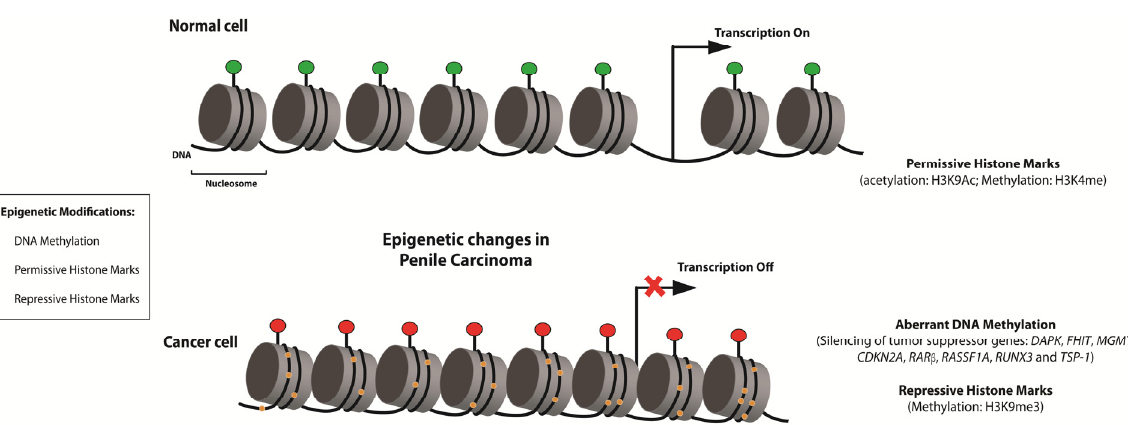
Figure 2. Epigenetic alterations were described in eight studies of penile carcinoma (PeCa). Aberrant DNA methylation pattern of DAPK , FHIT , MGMT , CDKN2A , RAR β , RASSF1A , TSP-1 , and RUNX3 and alteration in the expression levels of histones were events related with this disease. In special, CDKN2A gene was evaluated in six